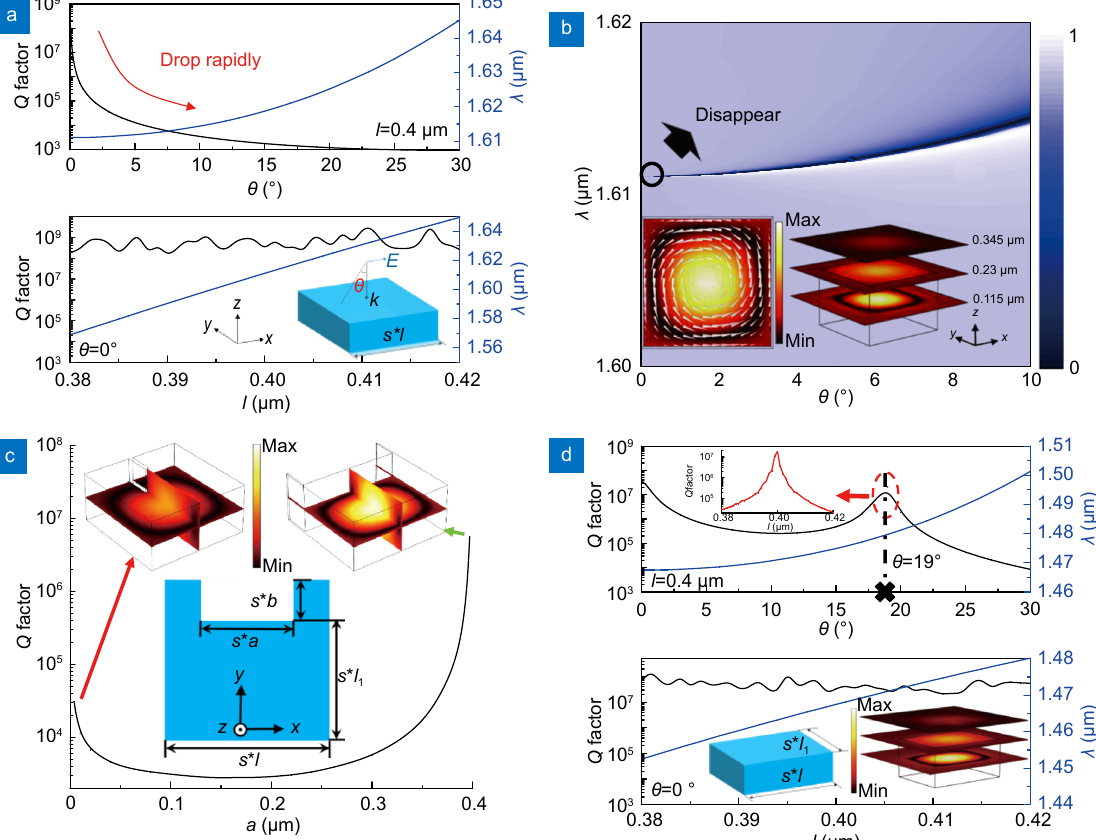
Fig. 1 | ( a ) Simulated Q factor and resonant wavelength as a function of θ (top) and l (bottom), respectively. Inset: the schematic view of the mod- el (a square block with l =0.4 μm). ( b ) Simulated transmission spectrum as a function of the angle and wavelength. Inset: the magnetic field pro- files under the normal incidence condition, where white arrows correspond to electric field vectors and the black wireframe outlines the single unit. ( c ) Modeled the Q factor as a function of a for a broken-symmetry square block ( l =0.4 μm). Bottom inset: the schematic image of the con- cave Si block. The top two insets show the magnetic field distributions at around a =0 μm and a =0.4 μm, respectively. ( d ) Simulated Q factor and resonant wavelength as a function of θ (top) and l (bottom) for the BIC mode at a =0.4 μm. The top inset: simulated Q factor as a function of l at θ =19°. The bottom left inset: the schematic view of the model (a rectangle block with l 1 =0.3 μm). The bottom right inset: the magnetic field profile at θ =0°. The scaling parameter is set as 1.2 in